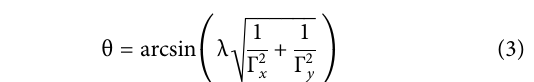
λ and Γ → ∞ , and the two main Figure 5E , Γ y = 8P = 3 x re fl ection beams are generated at (19.5 ° , 90 ° ) and (19.5 ° , 270 ° ), respectively (as the Figure 5F shows). For the Figure 5G , the phase codes changes in both x- and y-directions, and Γ x = 4 p = 1.5 λ , Γ y = 8P = 3 λ . According to Eq. 2 and Eq. 3 , we will obtain four